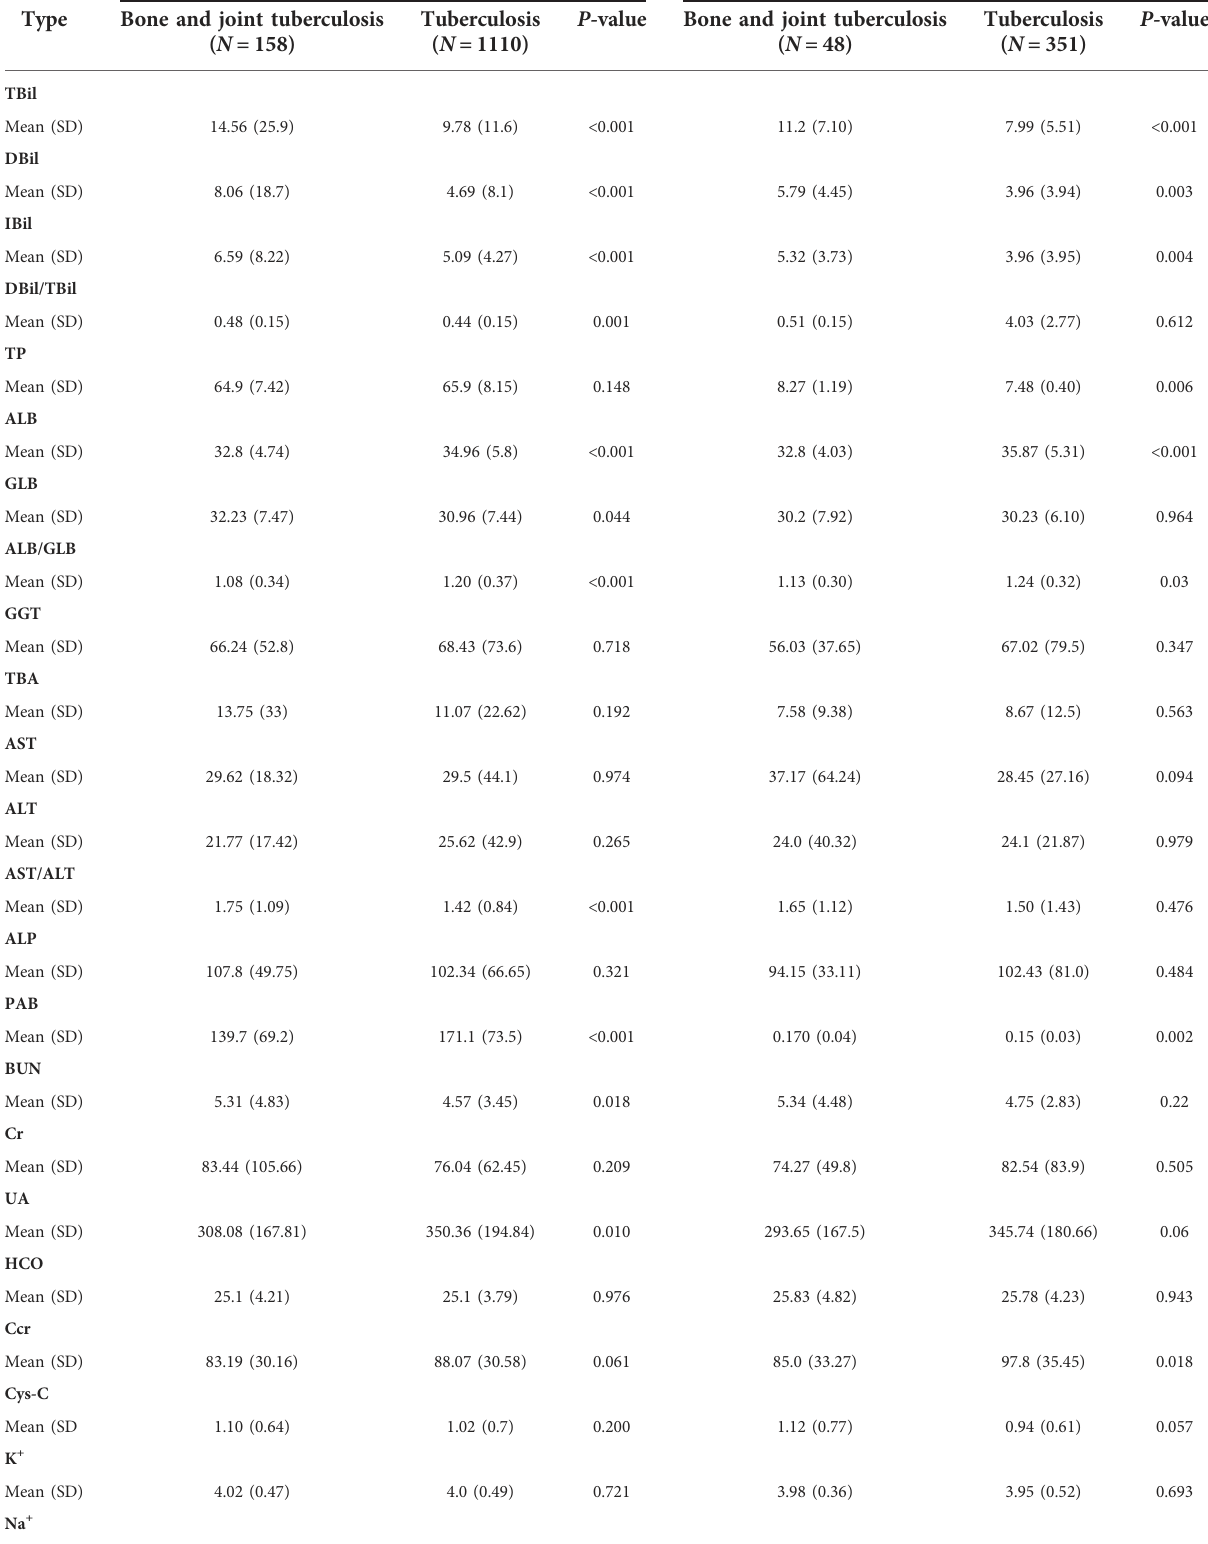
TABLE 2 The differences liver function examination, renal function examination and plasma electrolyte